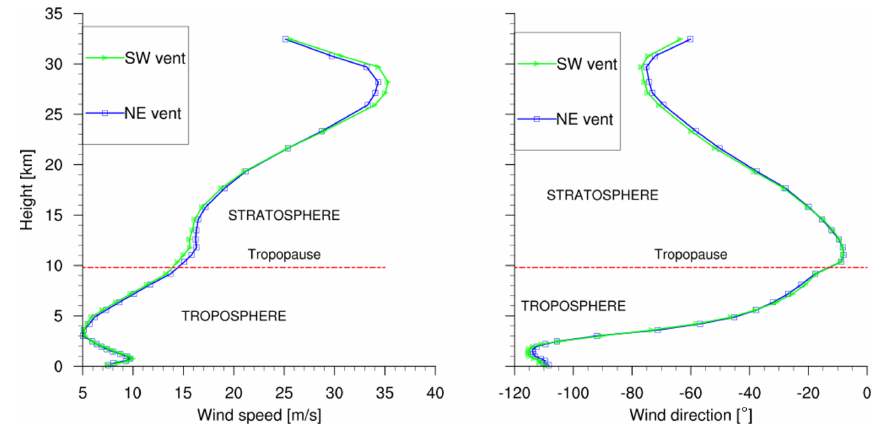
Figure 5. Monthly averaged ERA5 wind profiles (speed and direction) at two different locations (NE and SW) of JM.